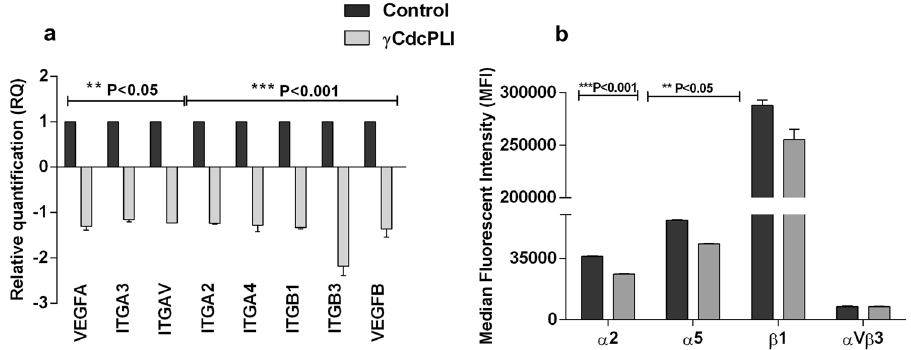
Figure 5. Gene and Integrin expression in HUVEC cells. ( a ) Relative quantification of genes expressed in HUVEC cells (VEGFA, VEGFB, ITGA2, TIGA3, ITGA4, ITGB1, ITGB3 and ITGBV) treated with γ CdcPLI 25 μ g/mL. ( b ) The graphic representation of median values of integrin expression in HUVEC cells treated with γ CdcPLI 50 μ g/mL. All data are expressed as mean ± S.E.M and all experiments were carried out in triplicate; differences between treatments and controls were analyzed by Unpaired t-test. Statistically significant: ** p < 0.05 and *** p <